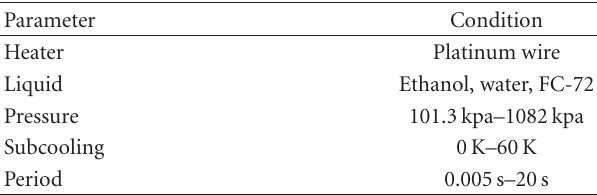
Table 1: Experimental